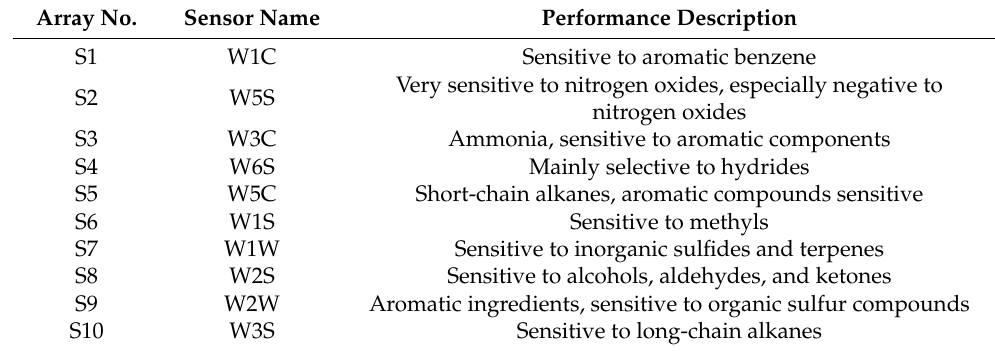
Table 1. Performance description of E-nose sensors. Array